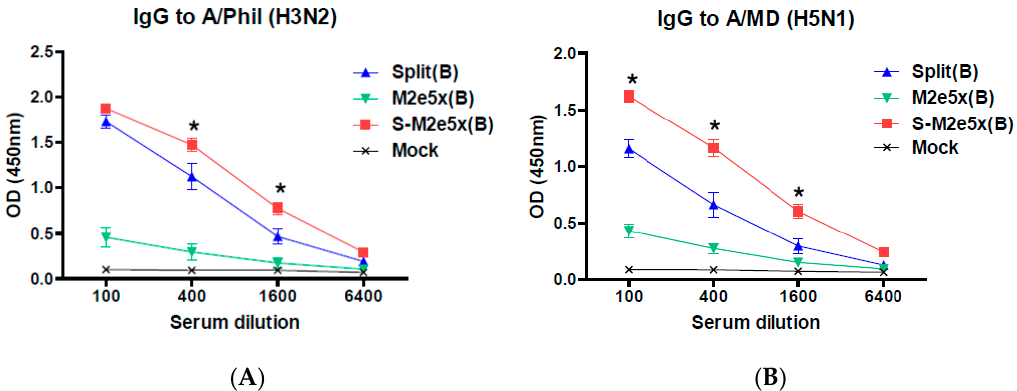
Figure 4. M2e5x VLP supplemented influenza split vaccination induces enhanced IgG antibody responses to di ff erent subtype viral antigens. BALB / c mice ( N = 6) were immunized with A / Cal split vaccine (Split), M2e5x VLP alone (M2e5x), or split vaccine supplemented with M2e5x VLPs (S-M2e5x). Sera collected 3 weeks after boost (B) vaccination were used to determine IgG antibody responses to di ff erent subtype viral antigens. ( A ) IgG antibody responses to influenza A / Phil (A / Philippines / 2 / 82, H3N2). ( B ) IgG antibody responses to influenza rgH5N1 (A / PR8 reassortant containing HA, NA, and